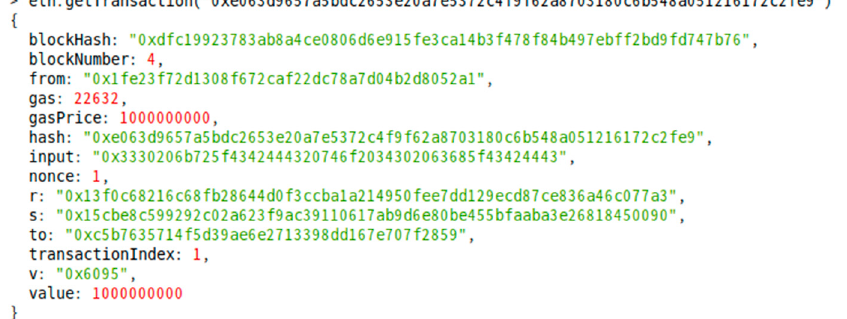
Figure 17. Generated transaction contents in Ethereum.